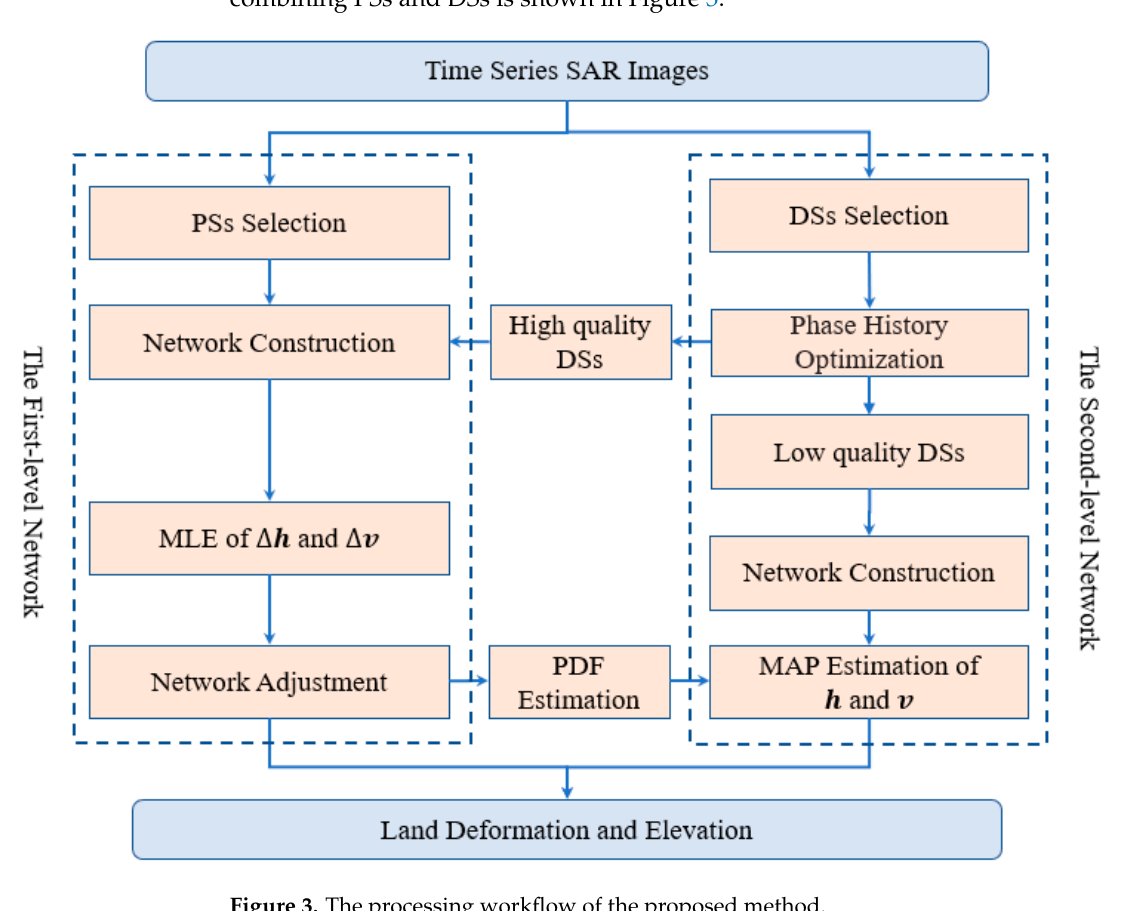
Figure 3. The processing workflow of the proposed method.